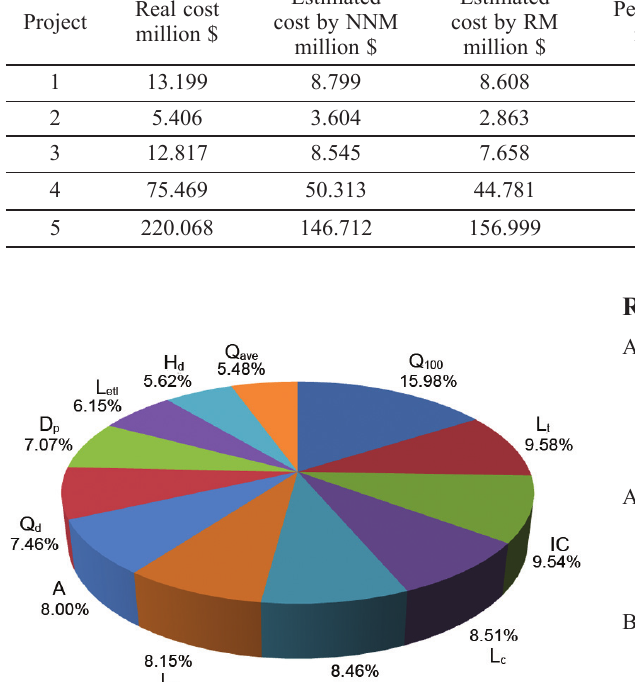
Table 5. Results of NNM and RM cost estimations